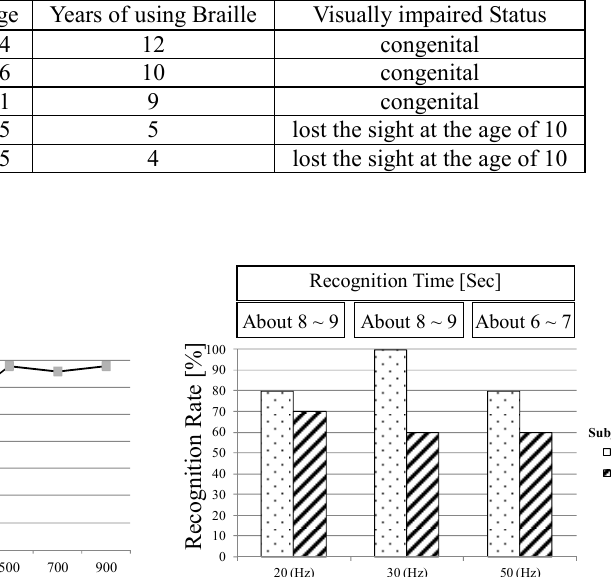
Fig.9 Braille Recognition Rate by Fig.10 Braille Recognition Rate by